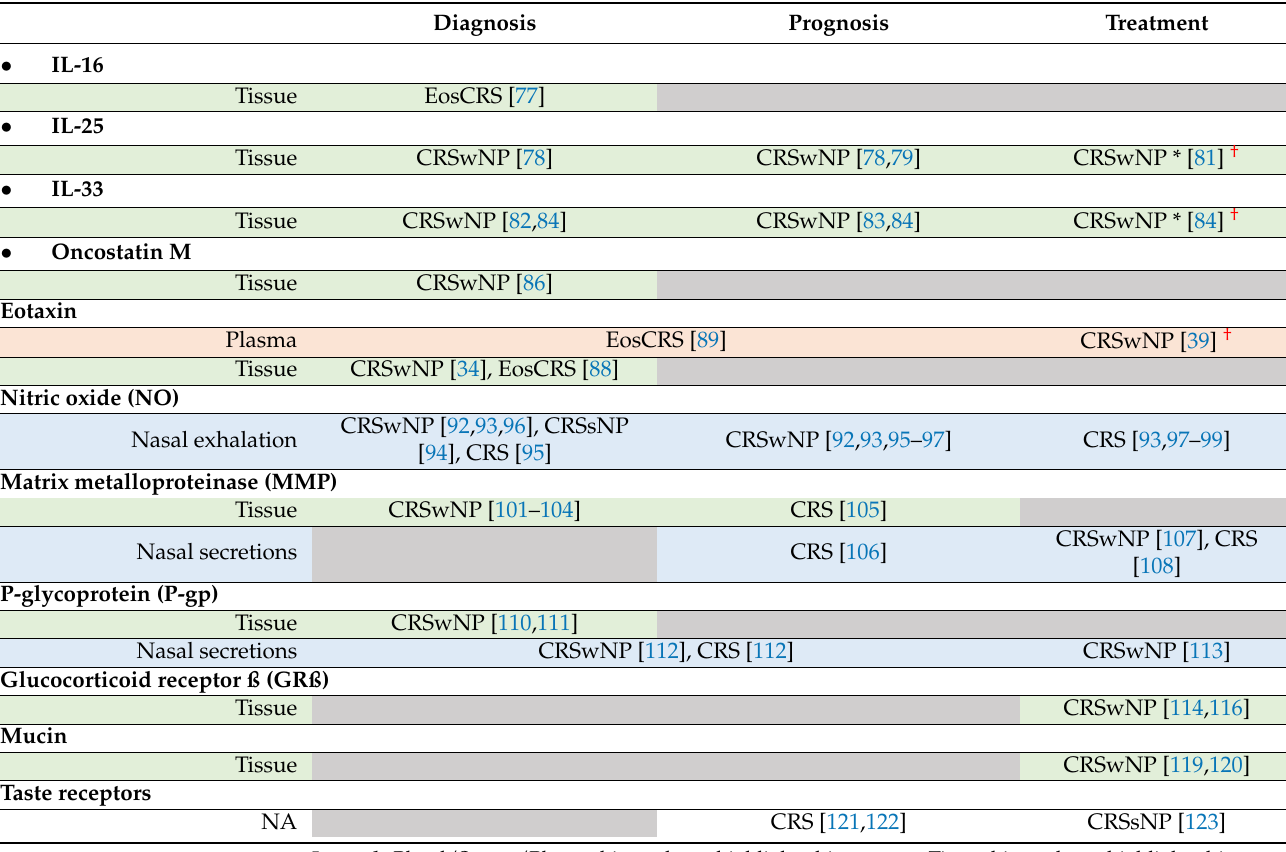
Table 1. Cont. Diagnosis Prognosis